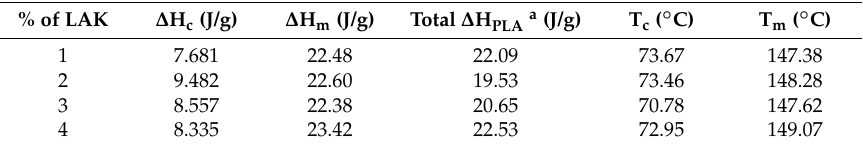
Table 5. DSC data related to PLA/EJ400/PBAT films.